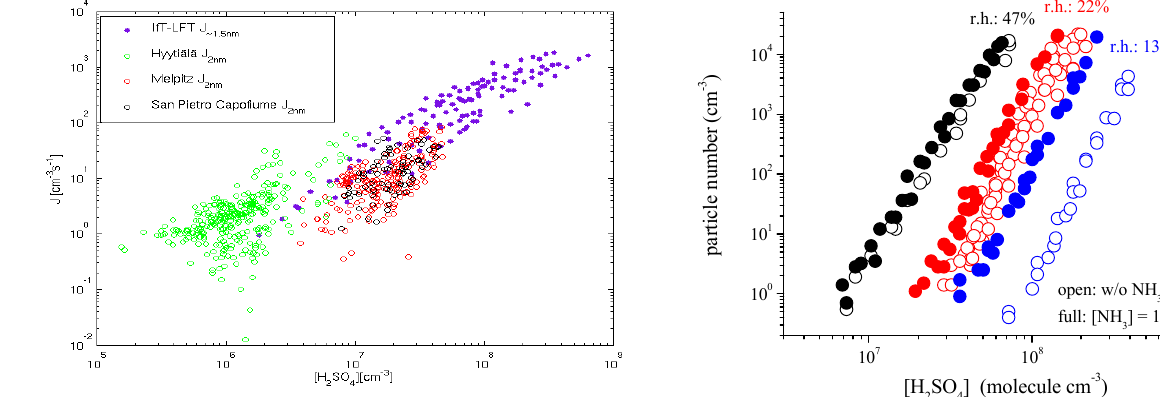
Fig. 2. Total particle number concentration as a function of the H 2 SO 4 concentration in nucleation experiments made at different relative humidities (r.h.). The experiments were conducted both in the presence of NH 3 (full circles) and with NH 3 concentration remaining below the detection limit (open circles).